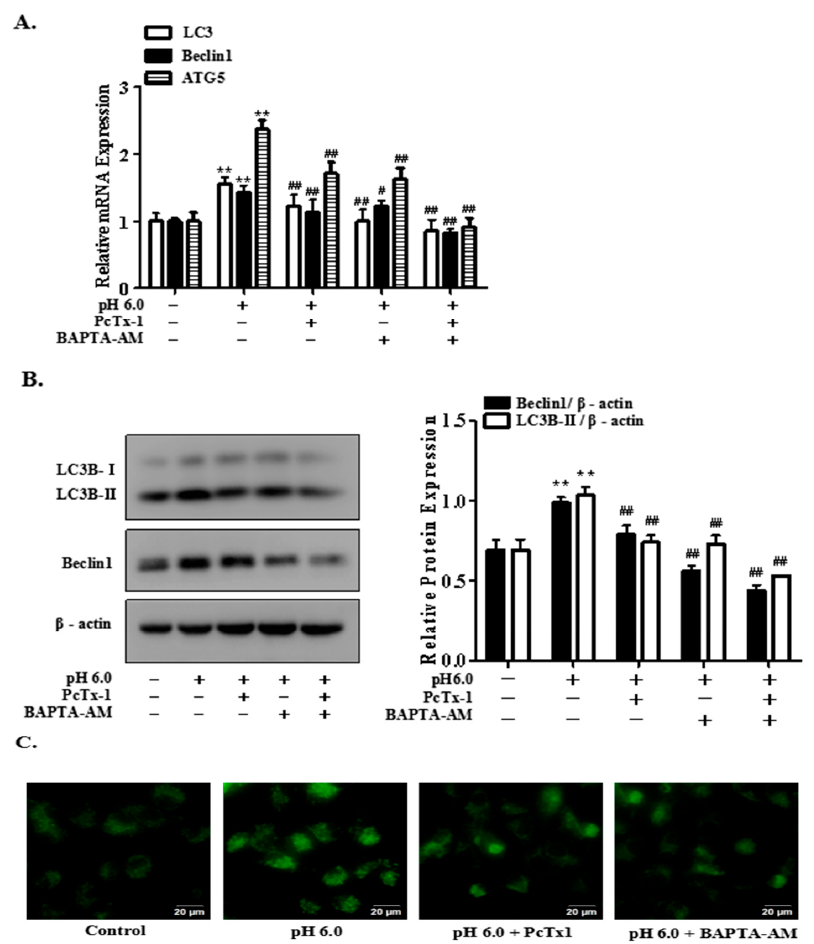
Figure 4. Blockade of ASIC1a and Ca 2+ with PcTx1 and BAPTA-AM suppresses acid-induced articular chondrocytes autophagy. Rat articular chondrocytes were incubated with or without ASIC1a-specific blocker, PcTx1 (100 ng/mL) and calcium chelating agent, BAPTA-AM (10 μ M) for 1 h, and then stimulated with extracellular acid (pH 6.0) for 3 h. ( A ) mRNAs were isolated from articular chondrocytes and qRT-PCR was performed; ( B ) the autophagy markers, Beclin1 and LC3B-II protein expression were determined by Western blotting; ( C ) monodansylcadaverine ( MDC) staining for acidic vacuoles was analyzed by fluorescence microscopy. Scale bar = 20 μ m. Values were presented as mean ± SD of three separated experiments. ** p < 0.01 versus control group; # p < 0.05, ## p < 0.01 versus pH 6.0 group.